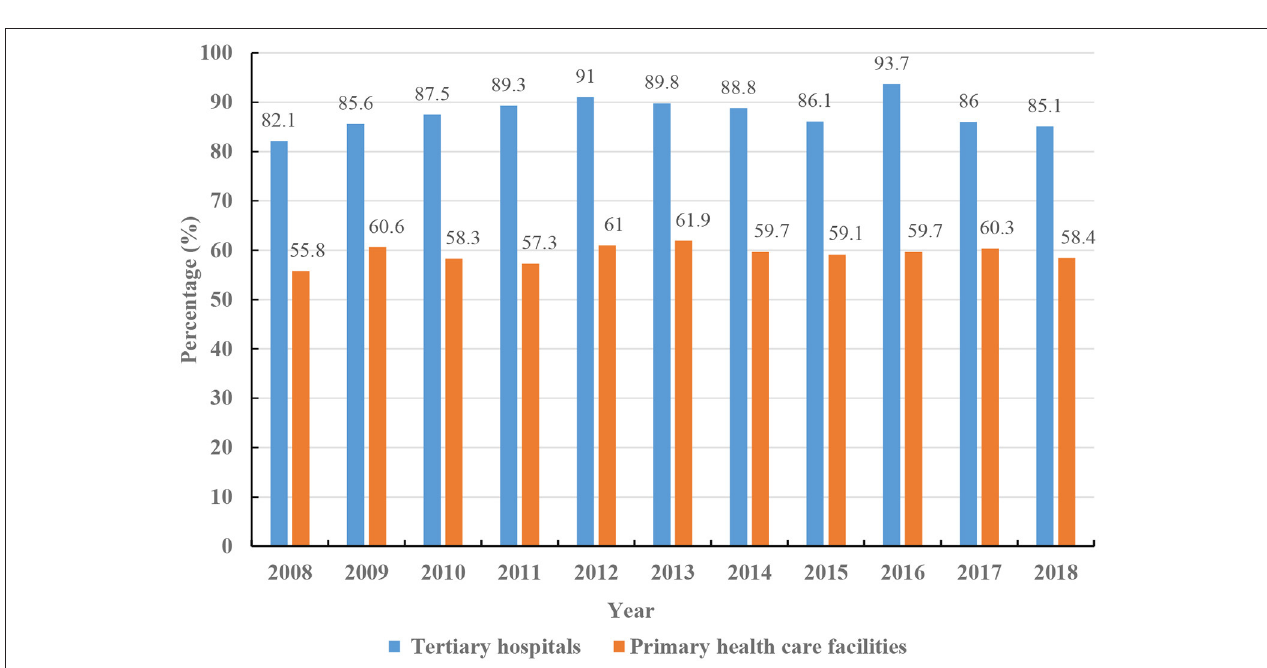
FIGURE 2 | The number of practicing (assistant) physicians per thousand in urban and rural regions in China.